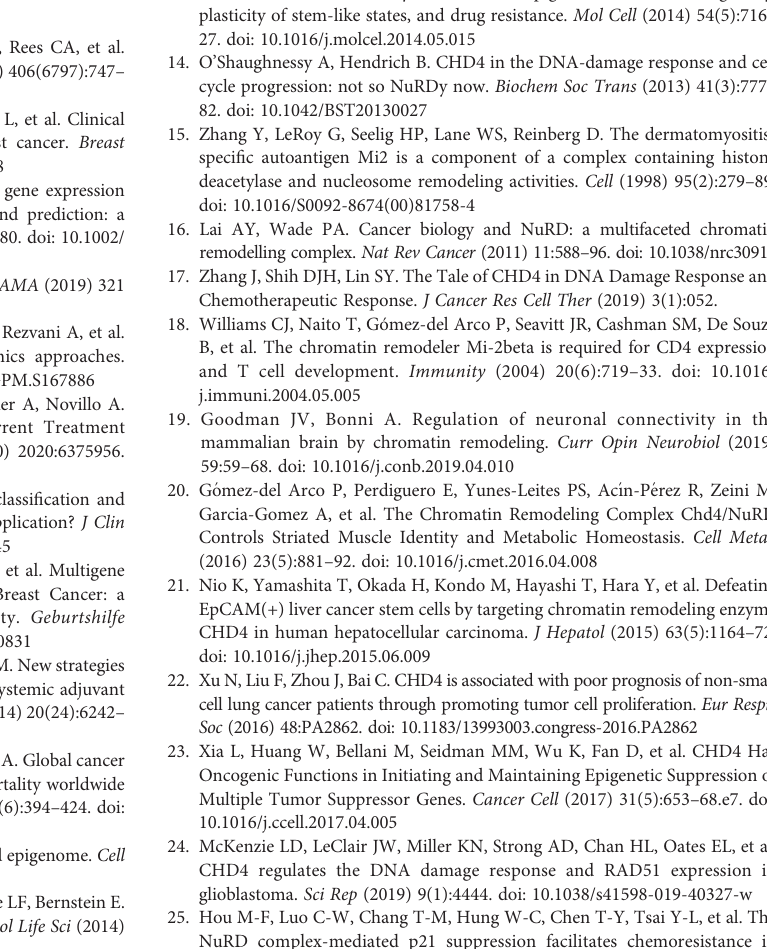
Supplementary Table 1 | Summary of studies and characteristics of CHD4 mutations in Breast Cancer. Data from cBioPortal, TCGA-BRACA and Cosmic